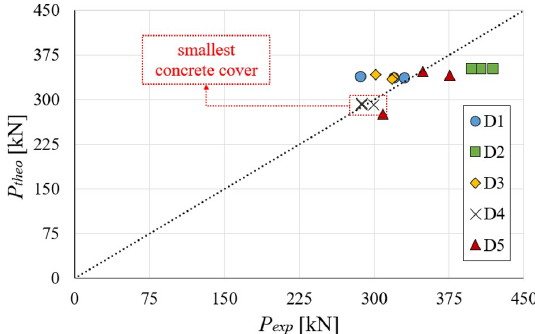
Figure 26. Comparison between experimental and analytical results.